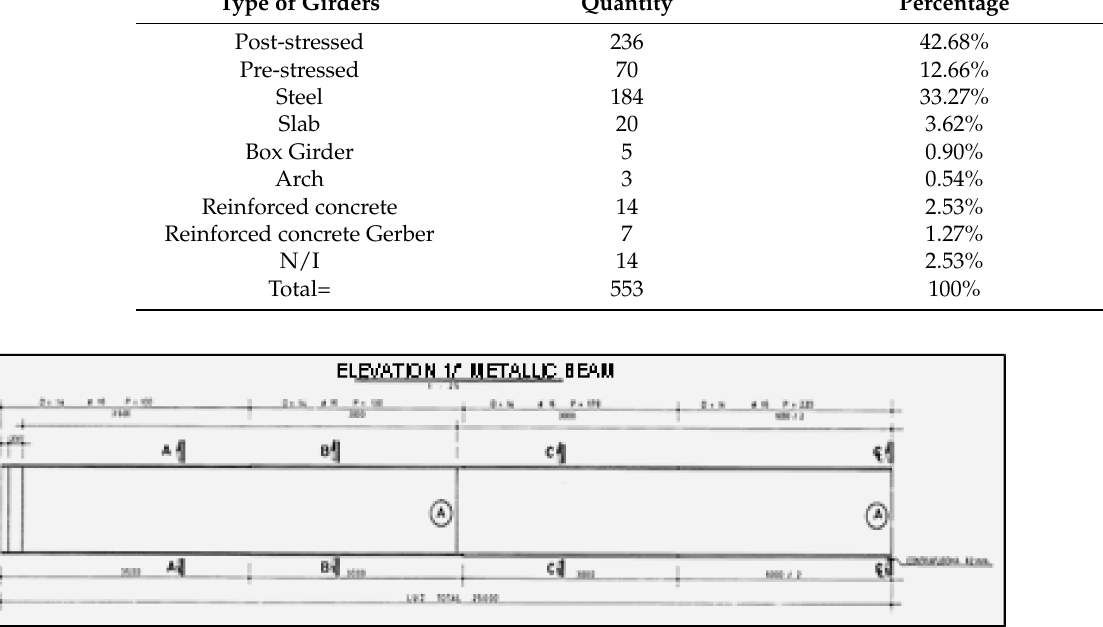
Figure 5. Original blueprint—steel girder in Chañar Blanco bridge. Girders with pre-stressed reinforcement appeared in the 1960s, and from the 1990s, their use became more frequent, with a particular focus on post-stressed girders. Such gird- ers are made of high-strength concrete, with a compression stress of between 350 kg/cm 2 and 380 kg/cm 2 . The pre-stressed reinforcement rebars are generally each made of seven- wire cables (Figure 6). The reinforcement is made of longitudinally and transversely assembled ribbed rebars, with A63-42H (fy = 420 MPa).